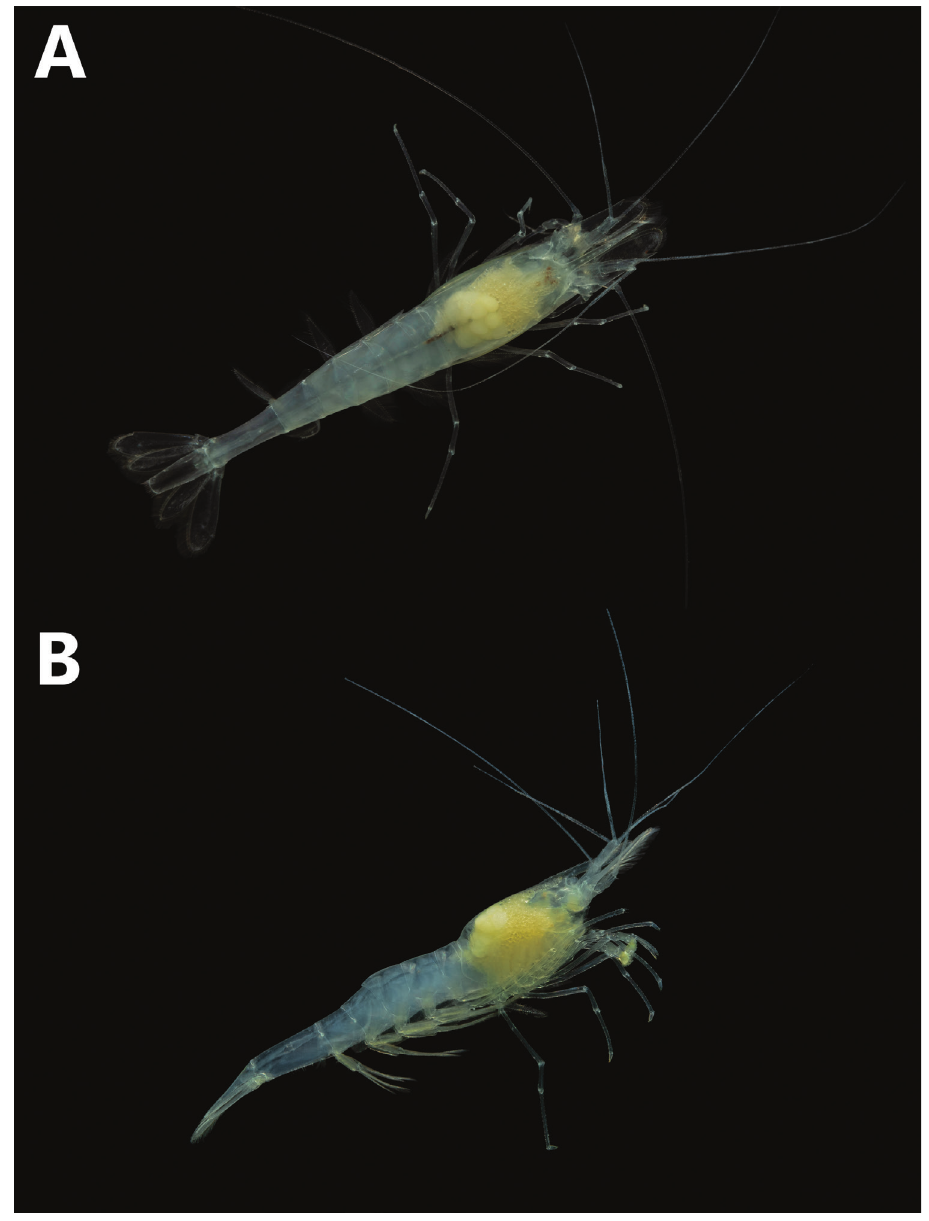
Figure 2. Photographs of the cave shrimp from Fern Cave, Jackson County, Alabama in life: dorsal ( A ) and lateral views ( B